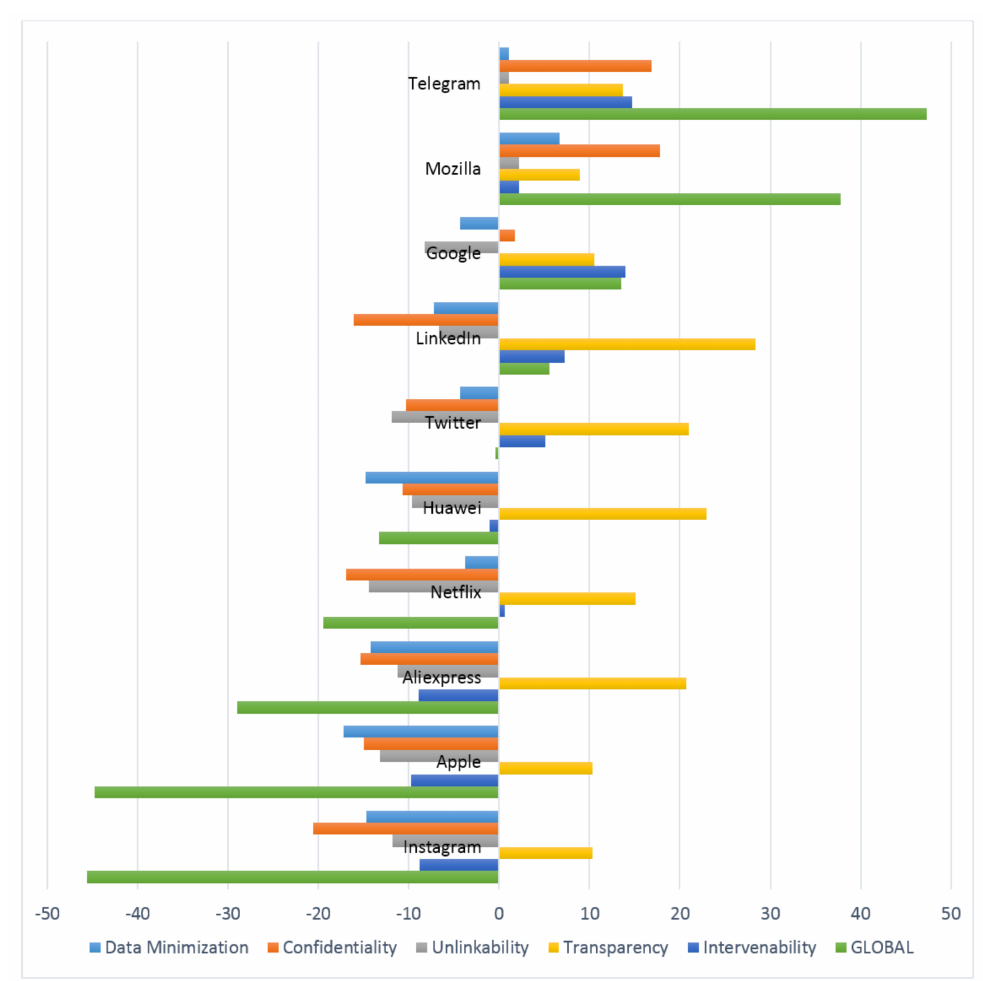
Figure 1. Per-goal and global scores (higher is better) of privacy policies of several services and companies, sorted from best to worst by their global